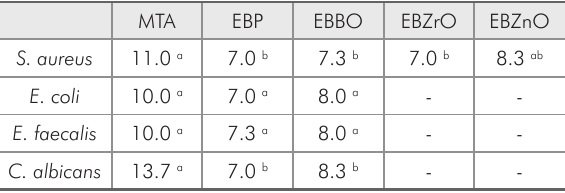
Table 4 - Mean values of inhibition halo diameters